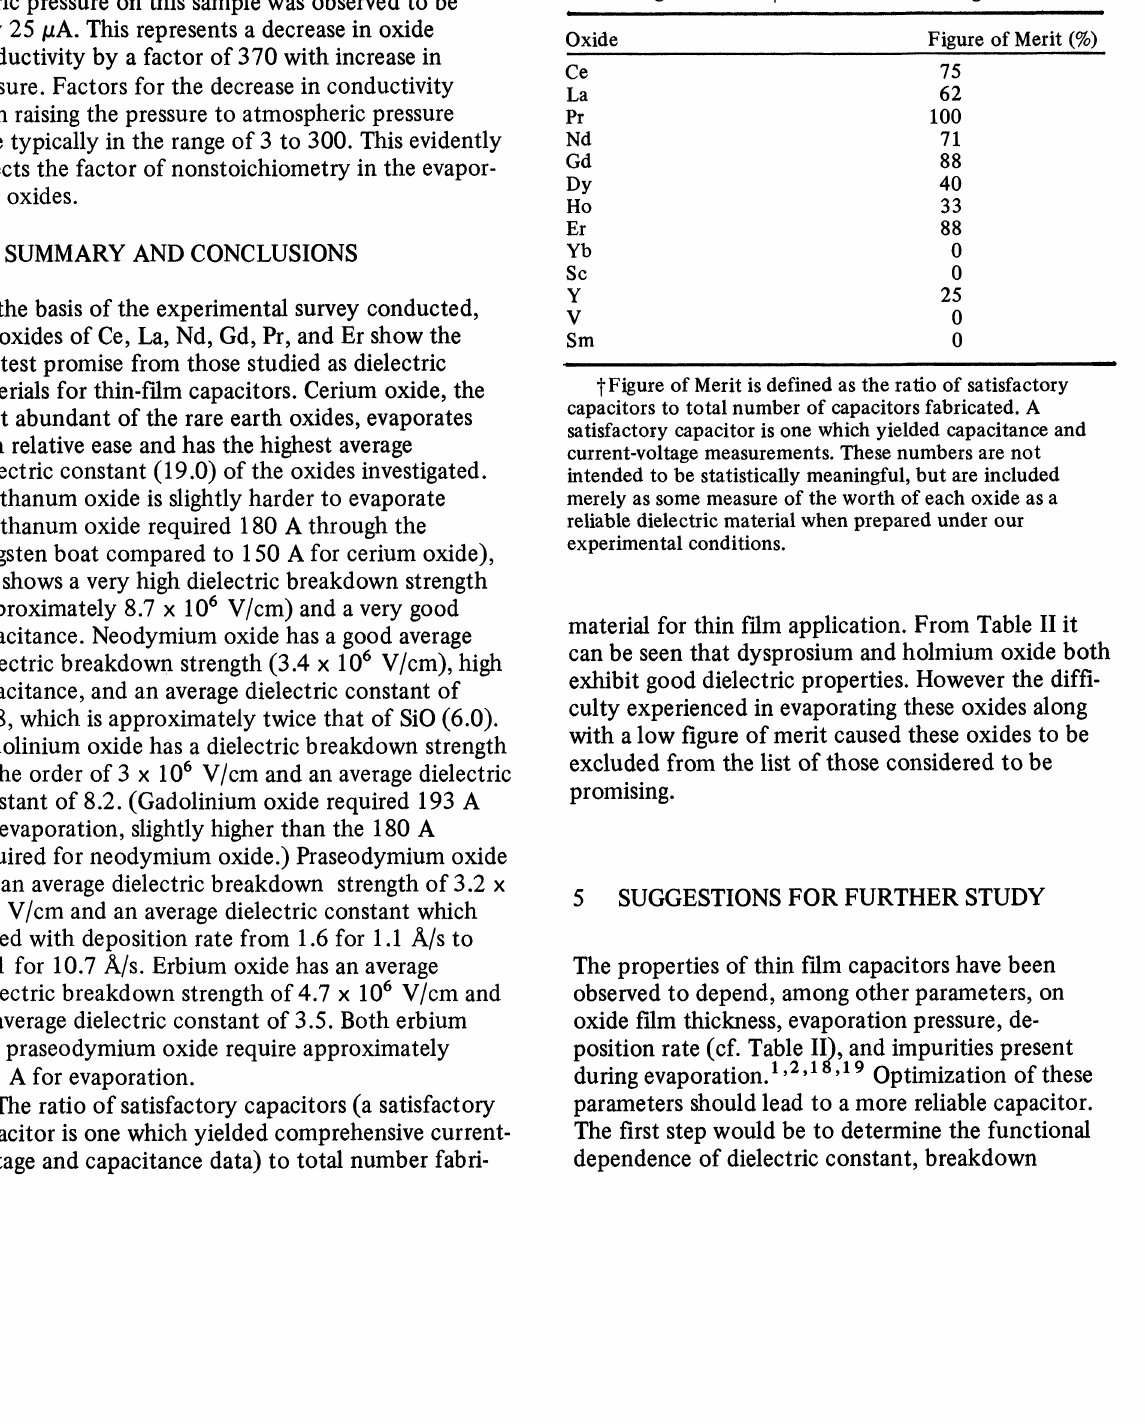
f Figure of Merit is defined as the ratio of satisfactory capacitors to total number of capacitors fabricated. A satisfactory capacitor is one which yielded capacitance and current-voltage measurements. These numbers are not intended to be statistically meaningful, but are included merely as some measure of the worth of each oxide as a reliable dielectric material when prepared under our experimental